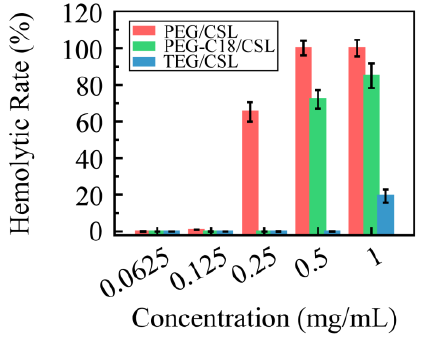
Figure 7. Hemolytic rate of CSL nanoparticles in normal red blood cells at 37 °C after 4 h incubation, n =